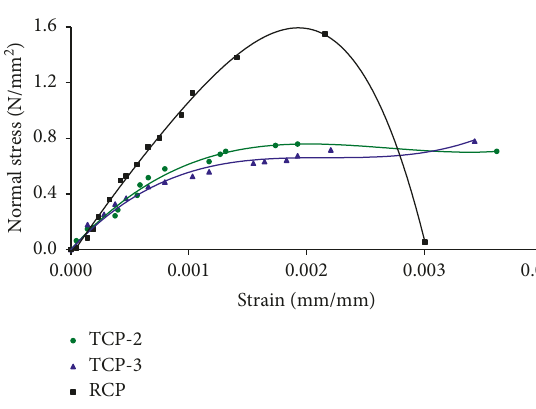
Figure 8: Bending stress-strain curve.